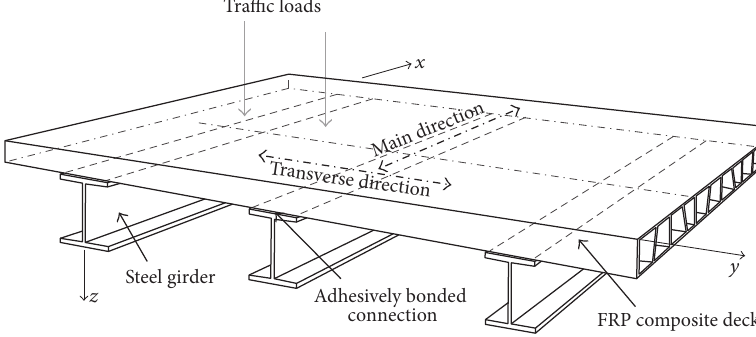
Figure 2: FRP composite to steel girder bridge system